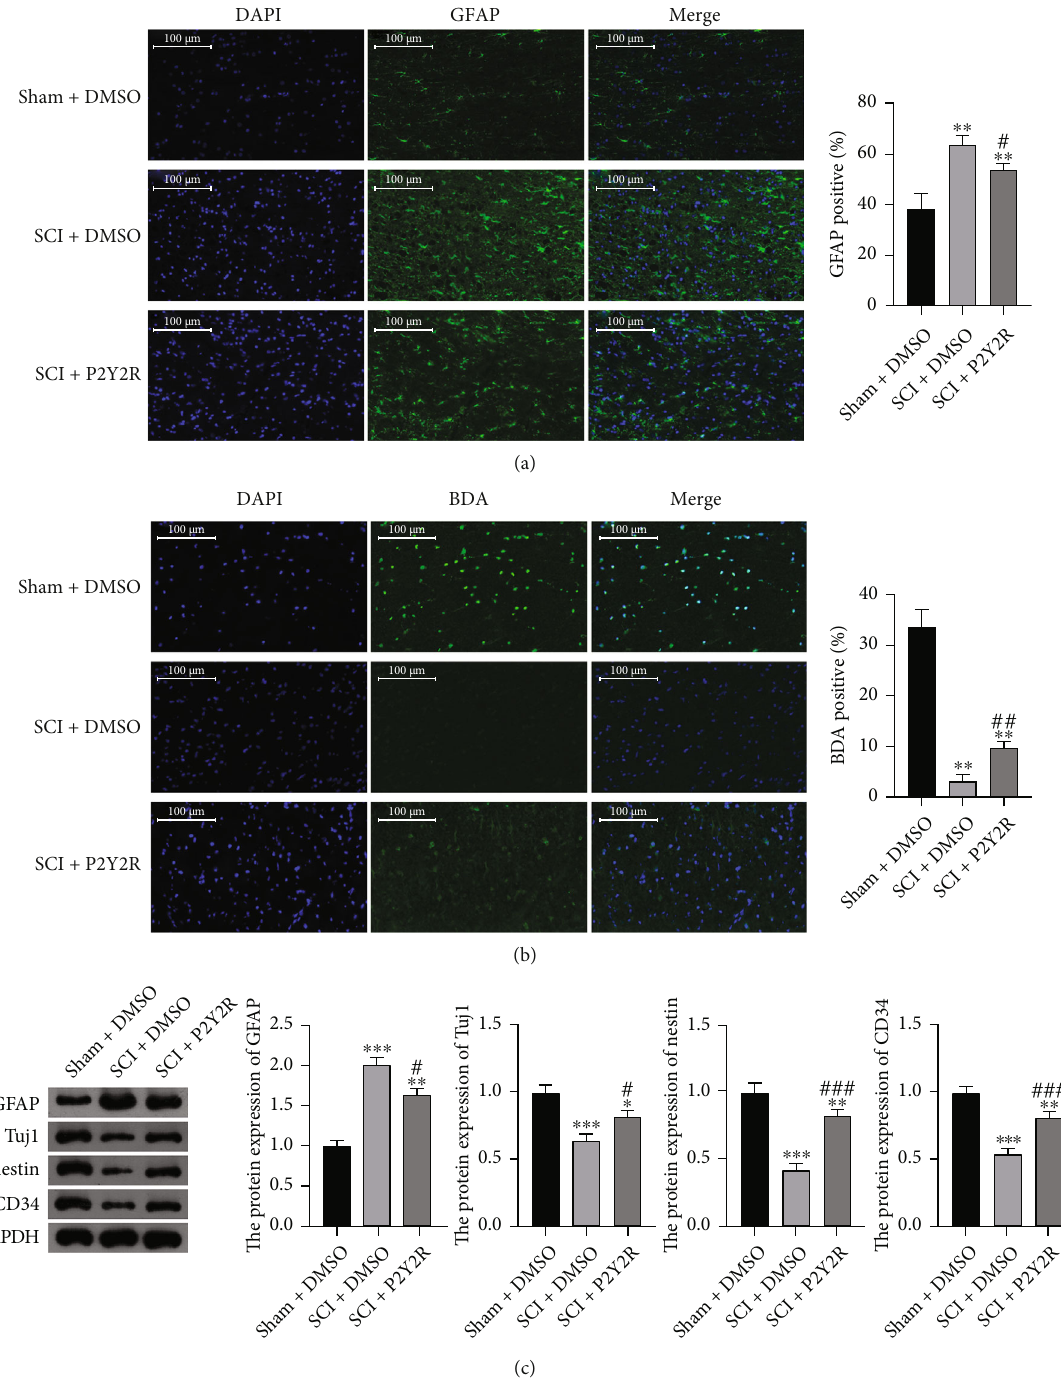
Figure 5: (a) The expression levels of GFAP detected by immuno fl uorescence staining. (b) Results of BDA staining. Scale bar = 100 μ m. (c) The relative protein expression of GFAP, Tuj1, nestin, and CD34 measured by western blotting. ∗∗ p < 0 : 01 compared with sham+DMSO group; # p < 0 : 05 and ## p < 0 : 01 compared with the SCI+DMSO